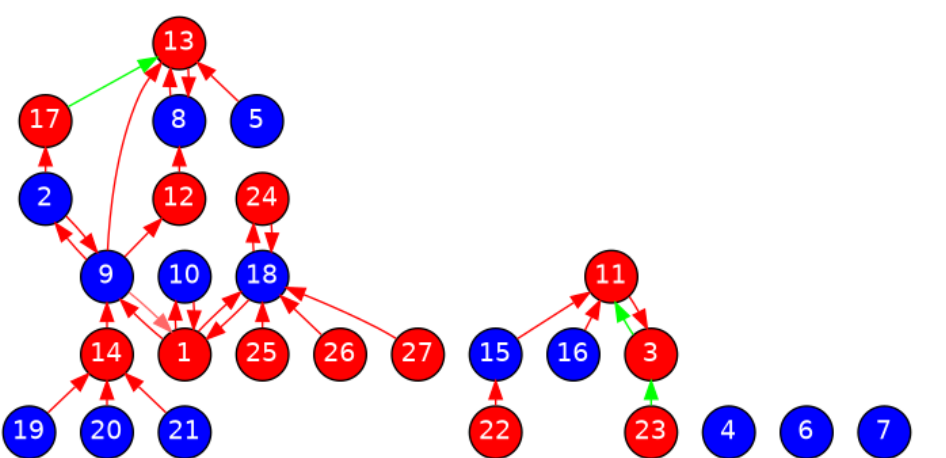
Figure 4. Bipartite graph showing sets L (red nodes) and R (blue nodes) after running Algorithm 1 using the UDebG of Figure 3 as input.